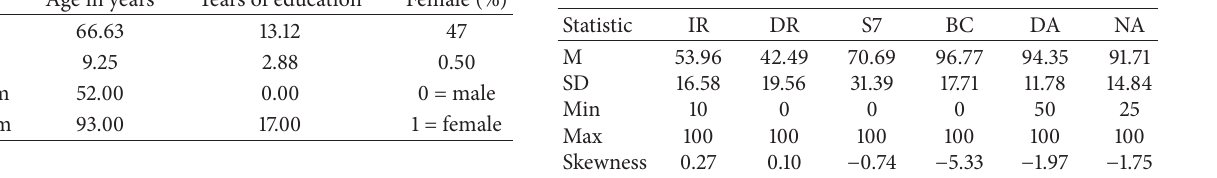
Table 1: Sample demographics at initial testing. Table 2: Descriptive statistics for cognitive measures at initial testing.